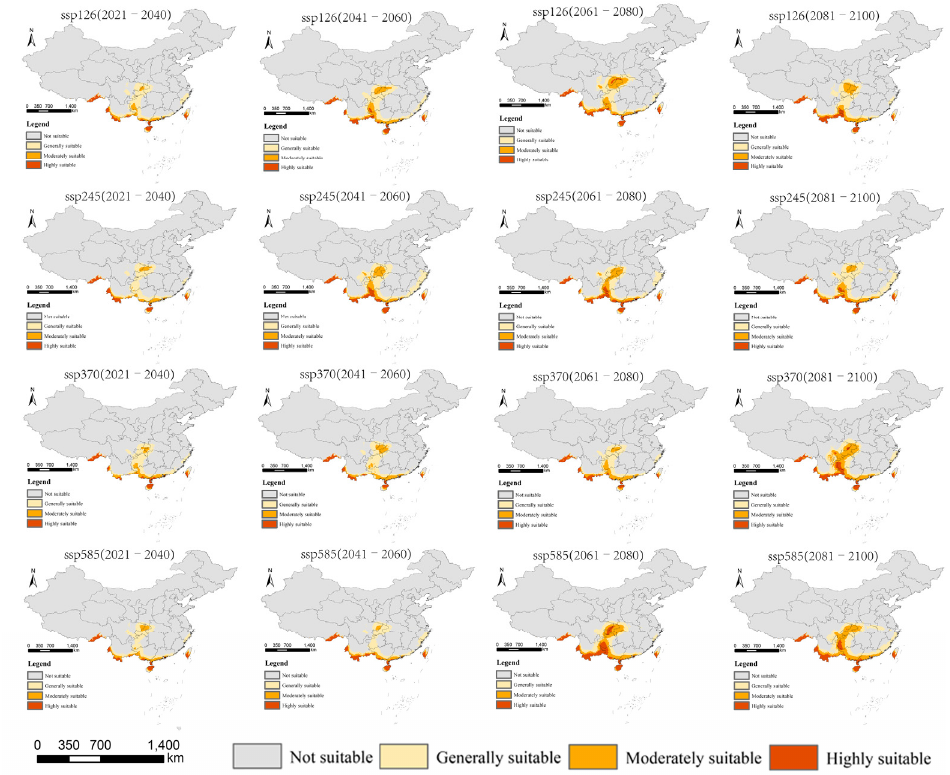
Figure 6. Potentially suitable areas for Anopheles nivipes in future climate scenarios using the MaxEnt model.